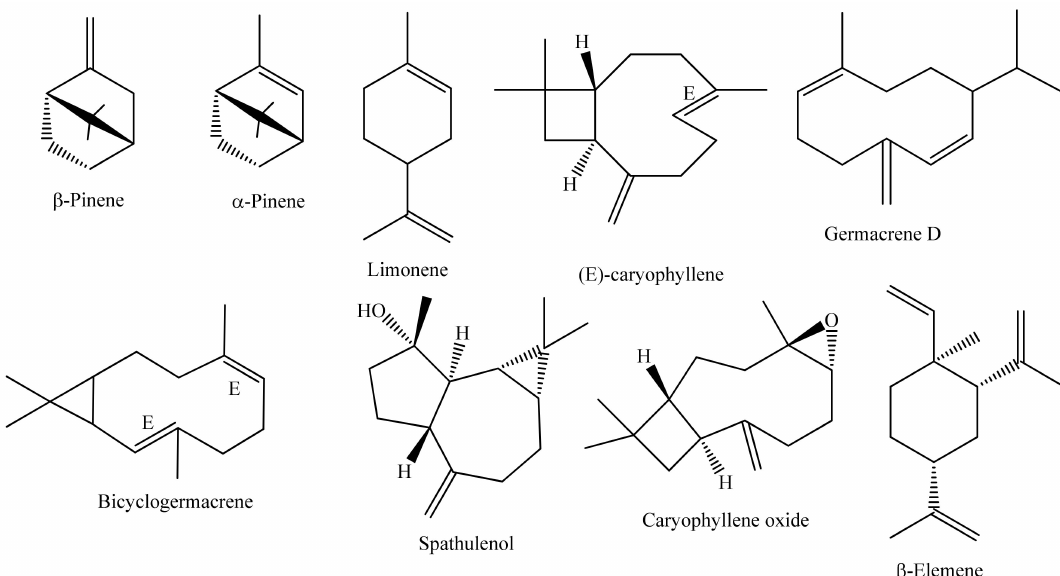
Figure 3. Structure of the major chemical constituents identified in the essential oils of Annonaceae species occurring in Brazil.